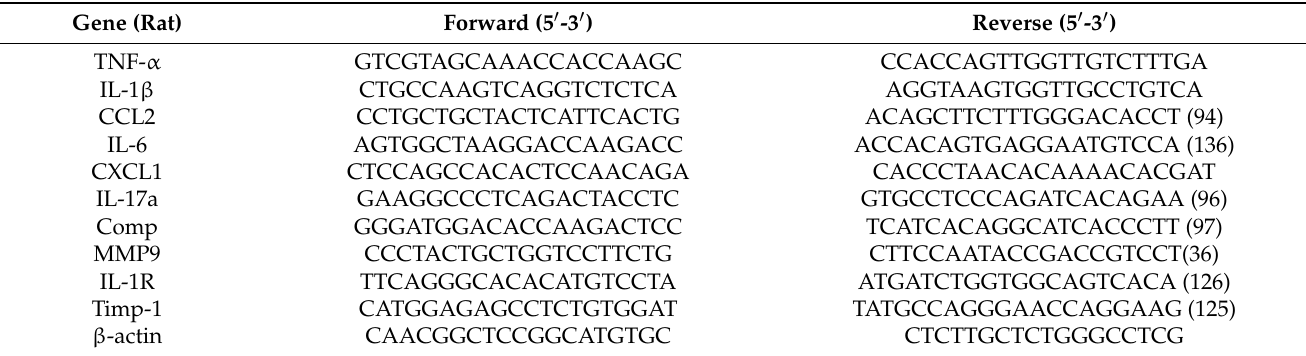
Table 2. Sequences of primer sets for real-time PCR